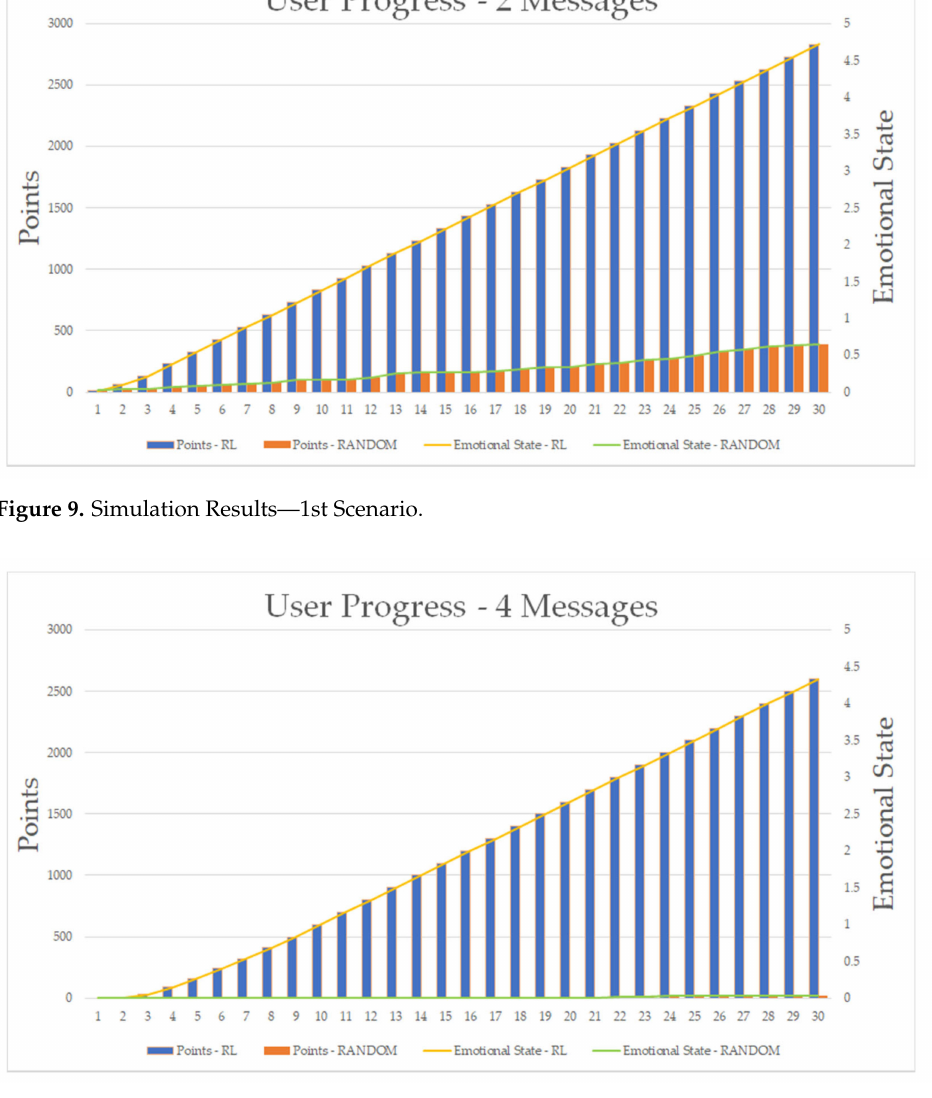
Figure 10. Simulation Results—2nd